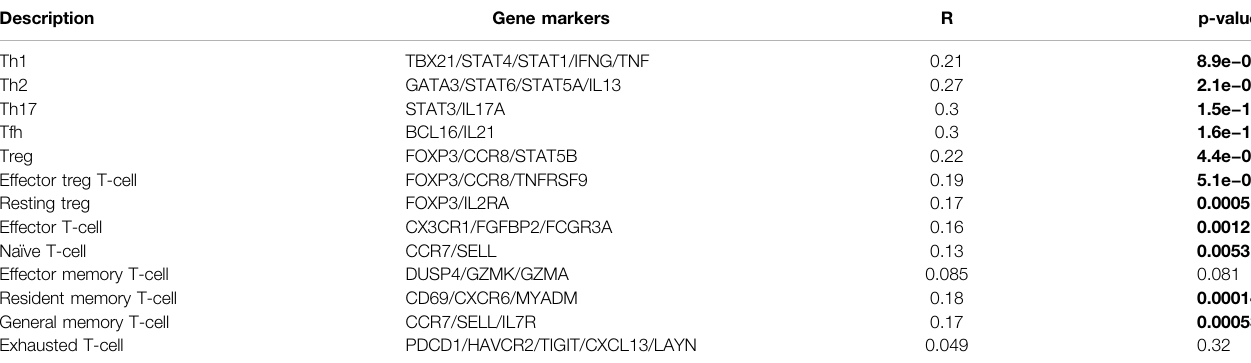
TABLE 4 | Spearman connection between CMTM6 and representative markers of different T cell subsets in GEPIA2. On the X-axis is CMTM6, and on the Y-axis are cell markers. The bold stands for statistical difference.